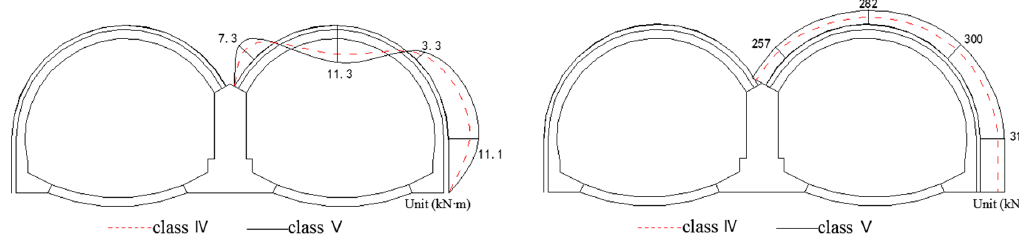
Figure 21. Final distribution of the bending moments and axial forces in steel arches in different classes of surrounding rocks.